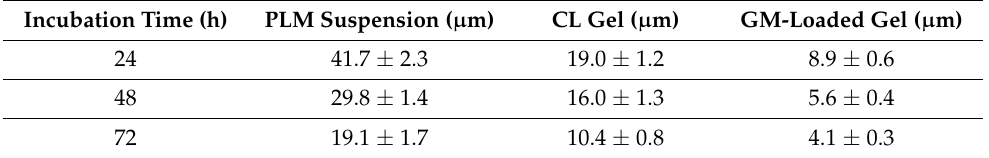
Table 5. IC 50 value of PLM suspension, CL gel and GM-loaded gel containing PLM in B16-F10 cell